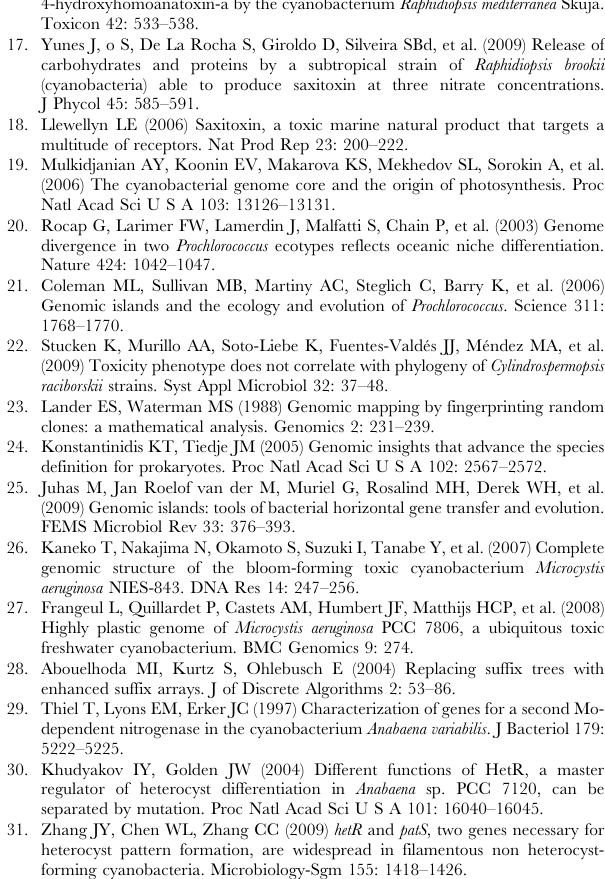
Figure S7 Comparison of the gene clusters for heterocyst polysaccharide biosynthesis. The comparison was based in the gene cluster described for Anabaena sp. PCC 7120 [51].